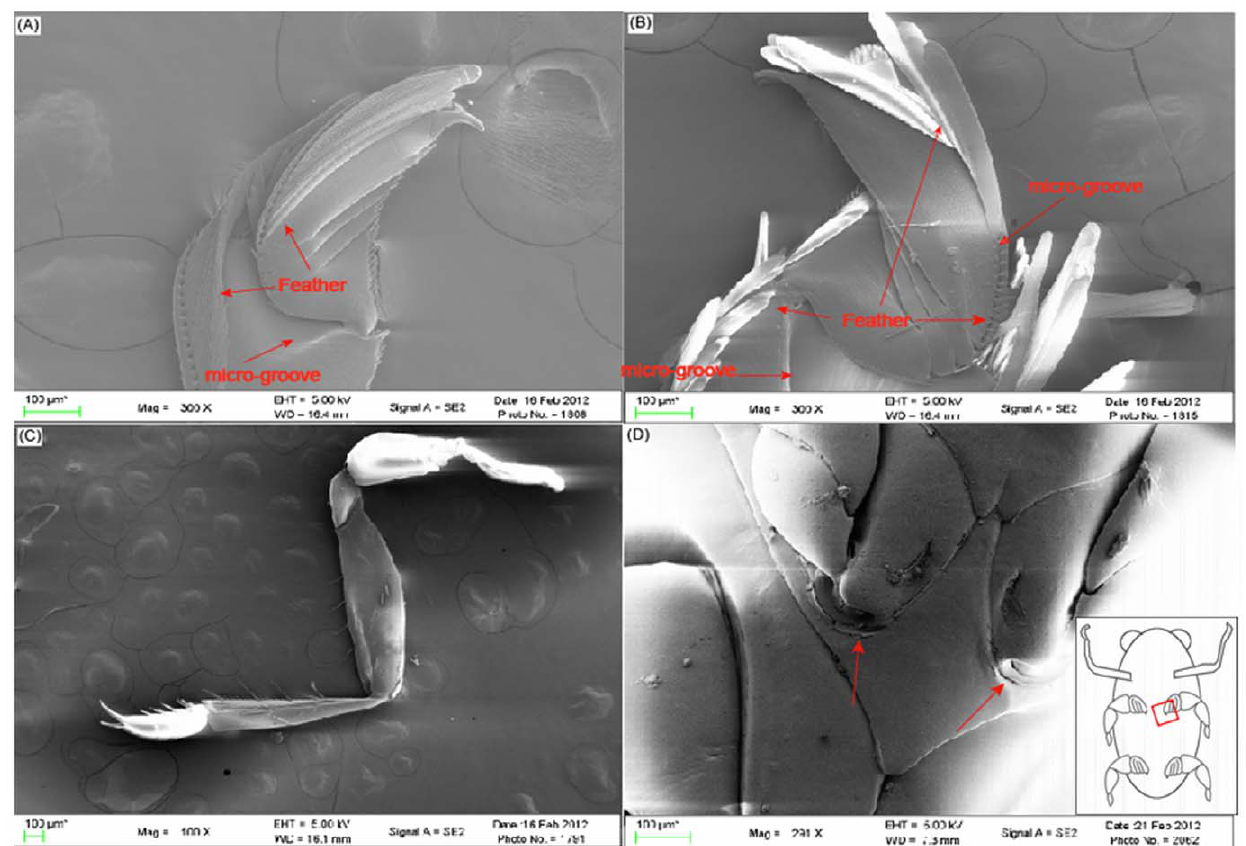
Figure 3. The SEM micrographs of the legs of Gyrinus . (A) SEM micrograph of the middle leg showing the folded swimming laminae. On the middle leg, the laminae are predominately on the outer surface. (B) SEM micrograph of the hind leg demonstrating the presence of laminae on both the inner and outer surface of the rowing blade. (C) SEM micrograph showing the significantly altered morphology of the foreleg. (D) Image of the point of attachment of a leg. The inset demonstrates the location of the micrograph relative to the beetle’s body, with the area analyzed highlighted by the red box. SEM micrographs were used to measure the length ( L laminae ) and width ( W laminae ) of the laminae for calculation of the effective are of the hind ( S h + ) and middle legs ( S m + ) with laminae extended. In all micrographs, the scale bar=100 m m.